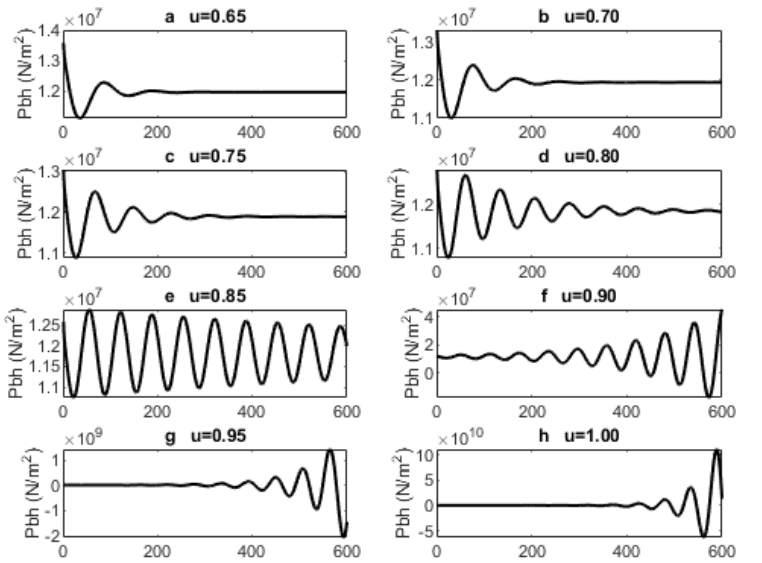
Figure 5. Step response of the linearised gas-lifted system in stable and unstable modes. The output is the downhole pressure, and the steady states correspond to input values from u = 0.65 to u =